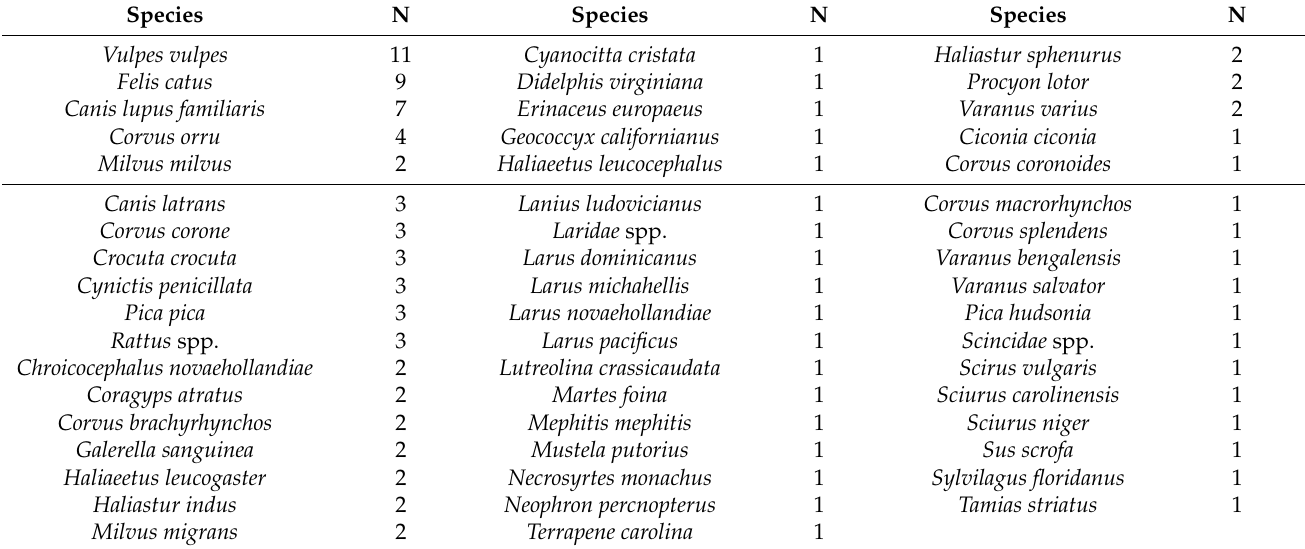
Table 2. Complete list of scavengers recorded in all articles reviewed. N is the number of studies that include each species. Species